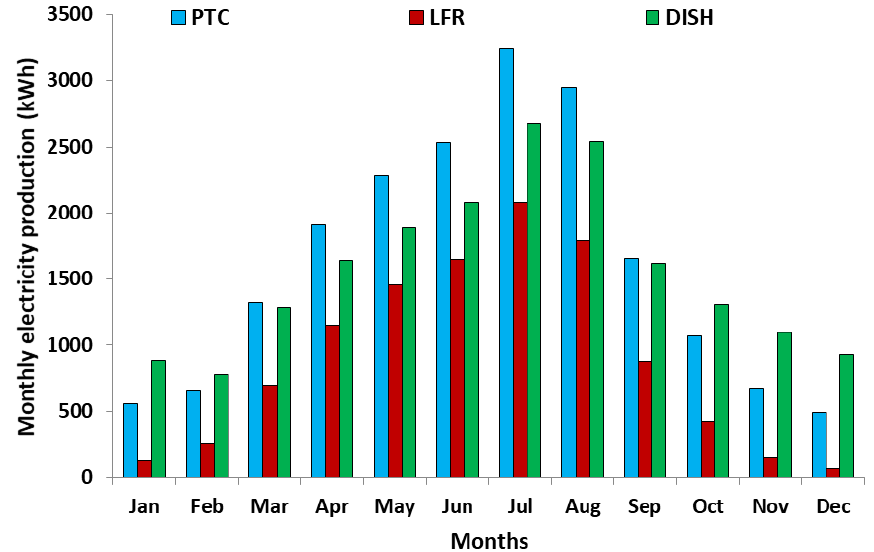
Figure 9. Monthly electricity production for the three solar collectors.